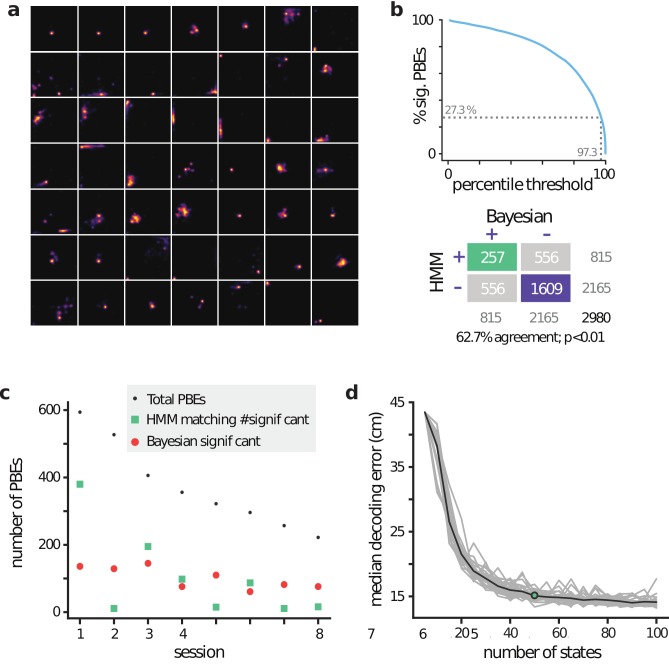
lsPF and position decoding in an open field.(a) lsPF for 49 of the 50 latent states from an example session. (b) (Top) Effect of model-congruence threshold on the number of significant PBEs. (Bottom) Comparison matrix between Bayesian replay detection and our model-congruence approach, where the threshold was chosen to match the total number of significant events pooled over all eight sessions. (c) Comparison between number of significant Bayesian events vs number of significant events using our model-congruence approach, when choosing the threshold as in (b). Sessions are ordered in decreasing numbers of total PBEs. Note that session one is a significant outlier, causing mismatches between many other sessions (2, 5, 7, 8), suggesting that matching on a per-session basis may be more appropriate in this case. (d) Median position decoding error (via the latent space and lsPF) was evaluated using cross-validation in an example session (n=30 realizations for each model considered, shown in gray, mean shown in black), indicating that (i) the PBE-learned latent space encodes underlying spatial information, and (ii) that our PBE models are informative aboutthe underlying position over a wide range of numbers of states.